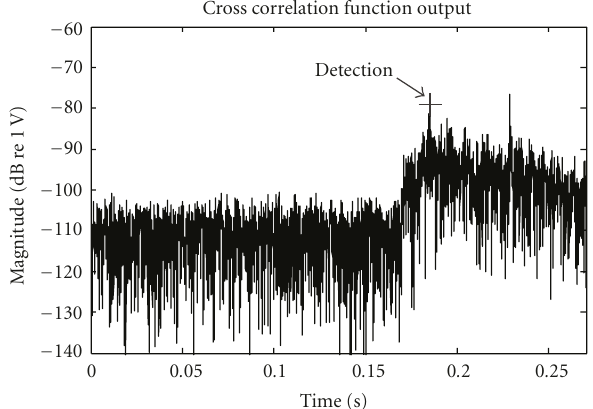
Figure 10: Extreme noise- and reverberation limited conditions.